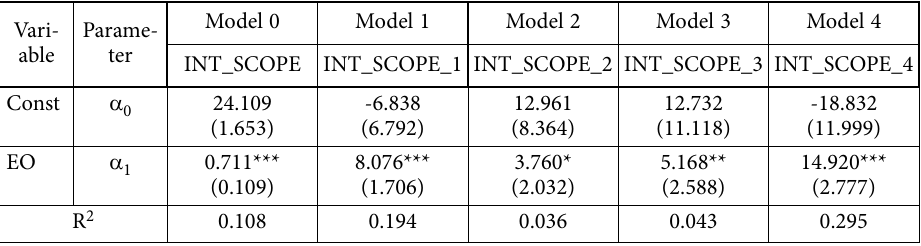
Table 4. Results of the linear regression model for the dependent variable “innovation index” (source: own elaboration based on a survey ( n =